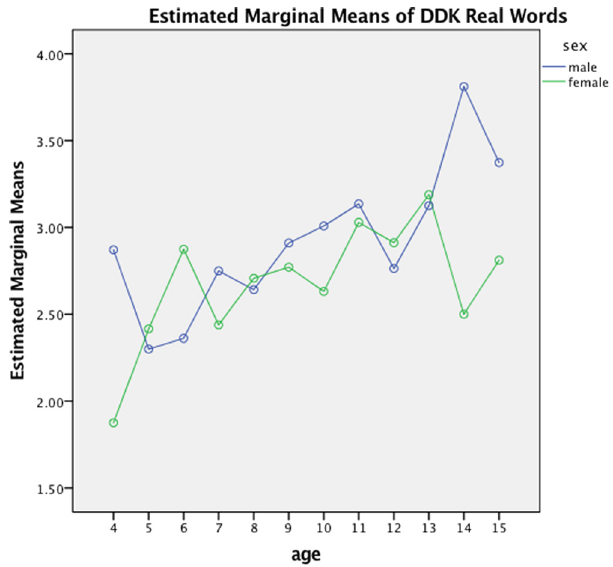
Figure 6: Age and gender e ff ects in mean total scores of real word stimuli repetition per second.